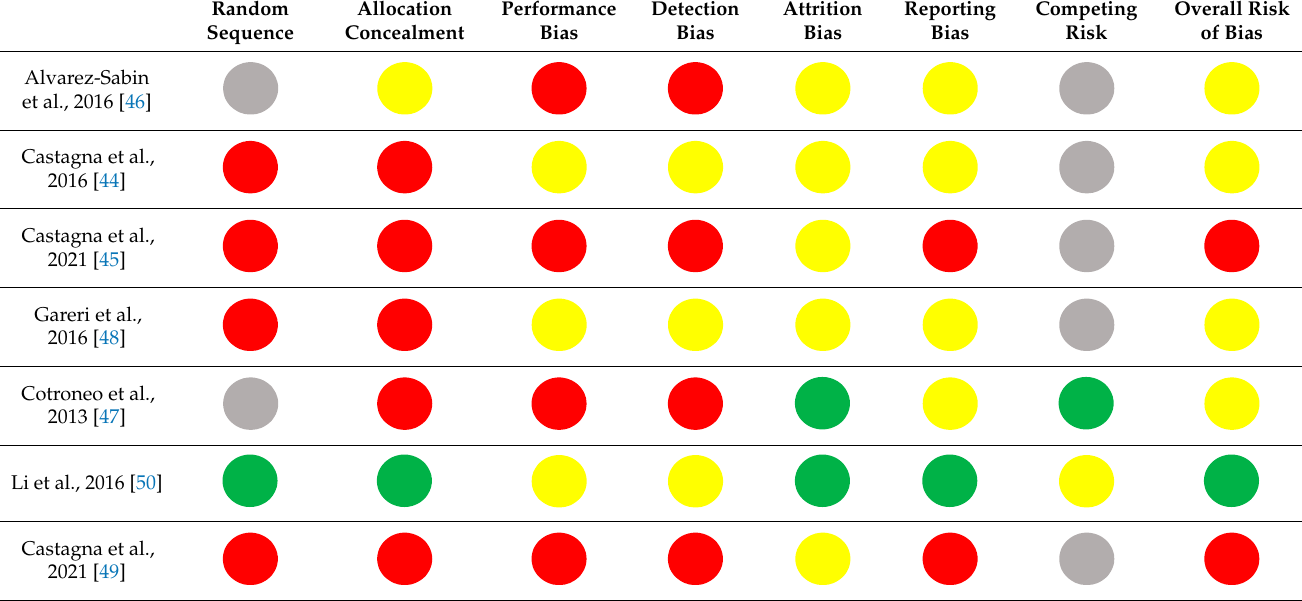
Table 3. Risk of bias of the included studies.